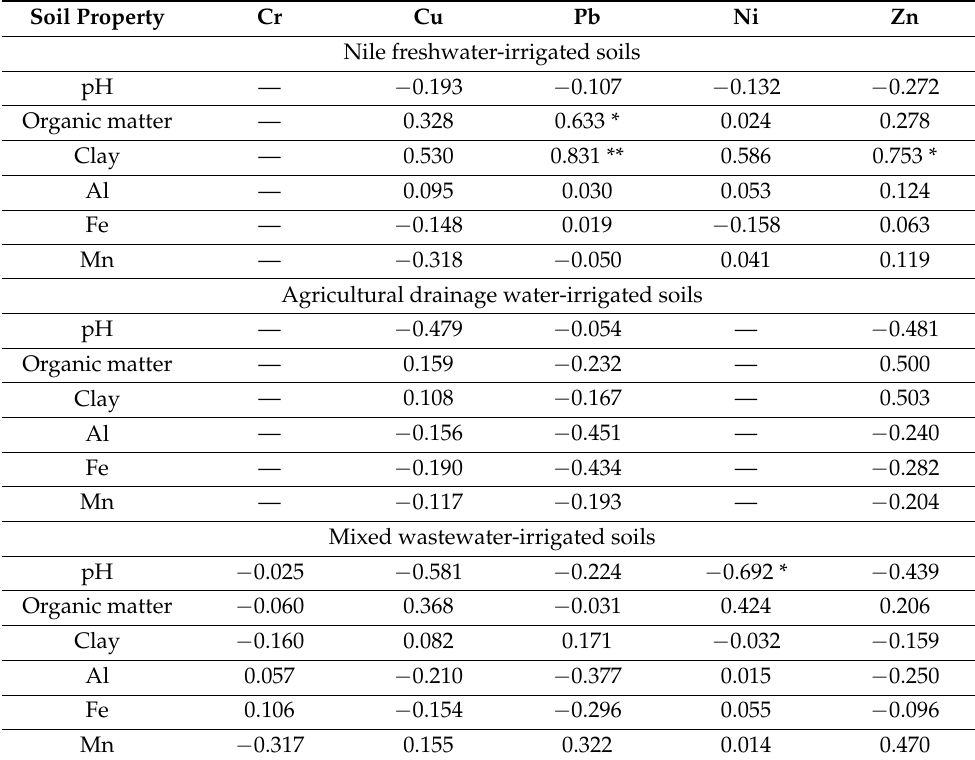
Table 5. Pearson’s correlation between metal availability ratio (AR) and